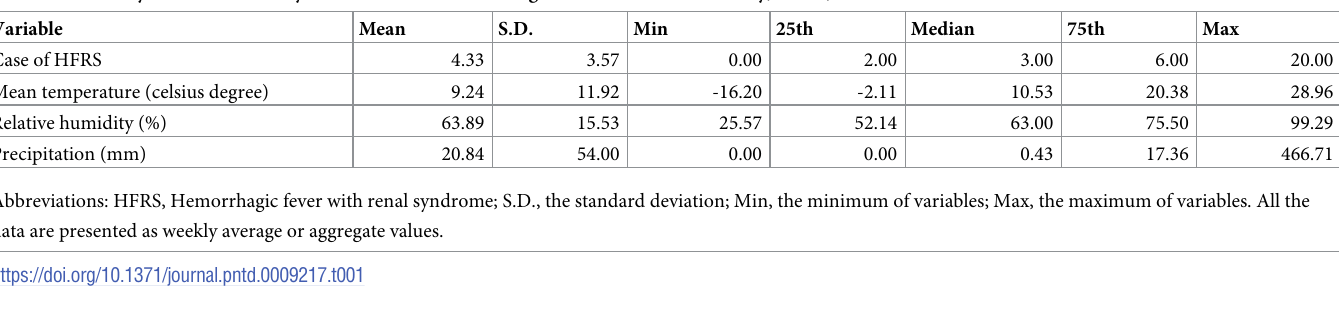
Table 1. Summary statistics of weekly HFRS cases and meteorological factors in Huludao City, China, 2007–2018. Variable